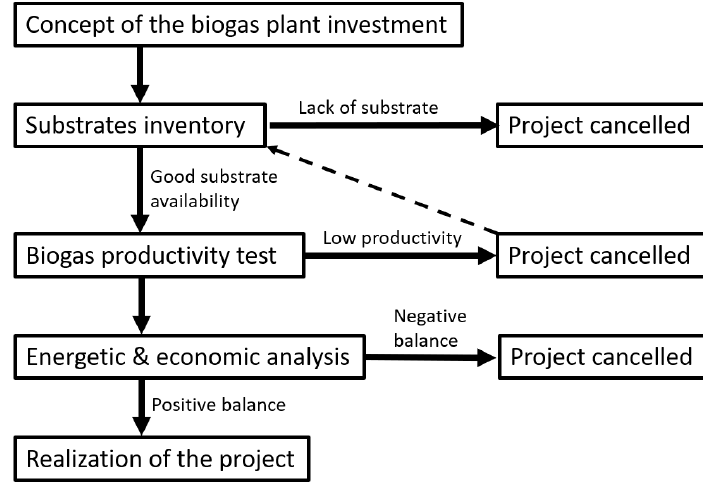
Figure 3. The flowchart of the proper way for making decisions for biogas plant investment.